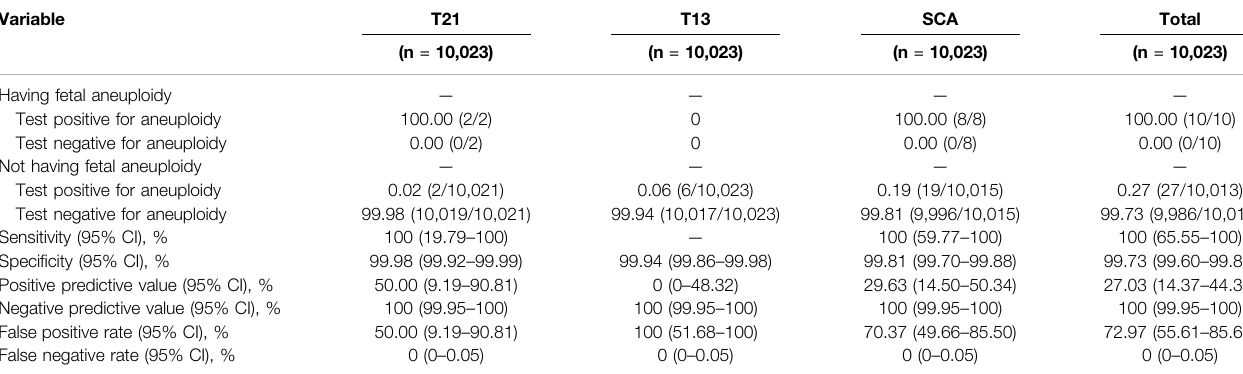
TABLE 3 | Clinical test performance of NIPS. Variable